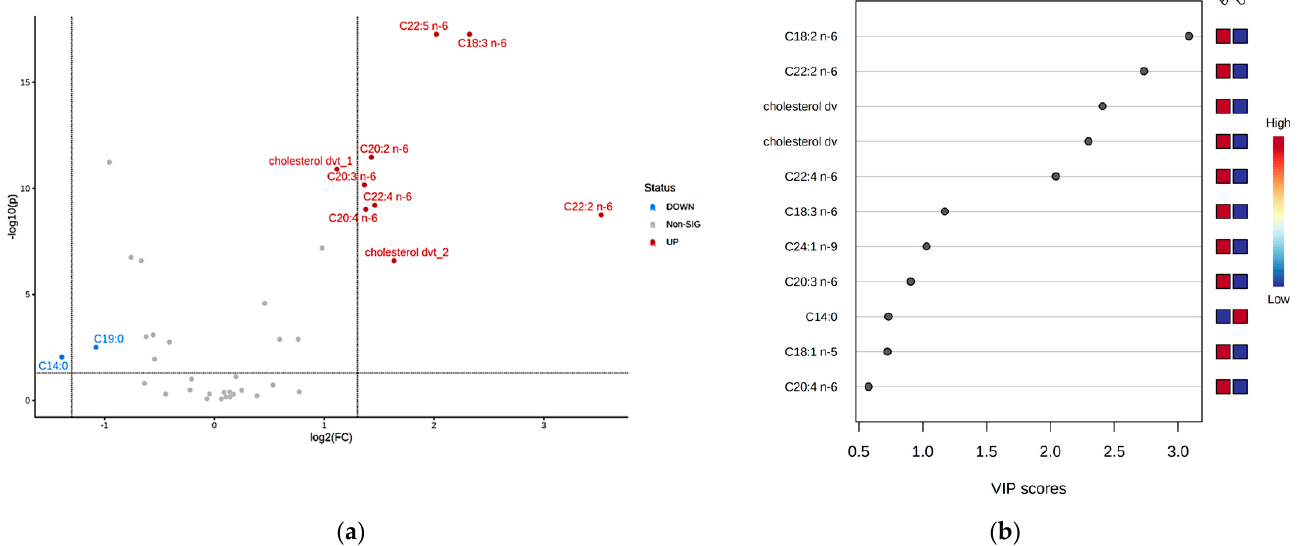
Figure 7. ( a ) Volcano plot of differentially expressed features (BT/UT). ( b ) PLS–DA: VIP score